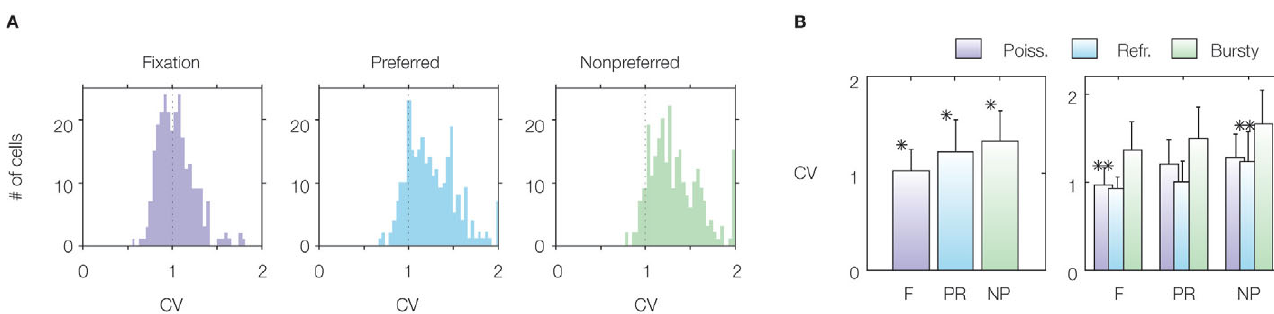
Figure 3 | Variability of spiking activity of prefrontal neurons of monkeys performing an ODR task. Measures of ISI variability are high in all epochs of the task. From Compte et al. (2003), used with permission. (A) Distribution of CVs over recorded cells for each task condition (FIXATION, F): before stimulus presentation; PREFERRED (PR): delay period following the preferred stimulus; NONPREFERRED (NP): delay period following the non-preferred stimulus). (B) Mean and SD of the CV in each task condition. The right panel shows mean and SD of the CV for three classes of neurons (‘Poisson’, ‘Refractory’, and ‘Bursty’) defi ned according to features of their power spectrum. See Compte et al. (2003) for more